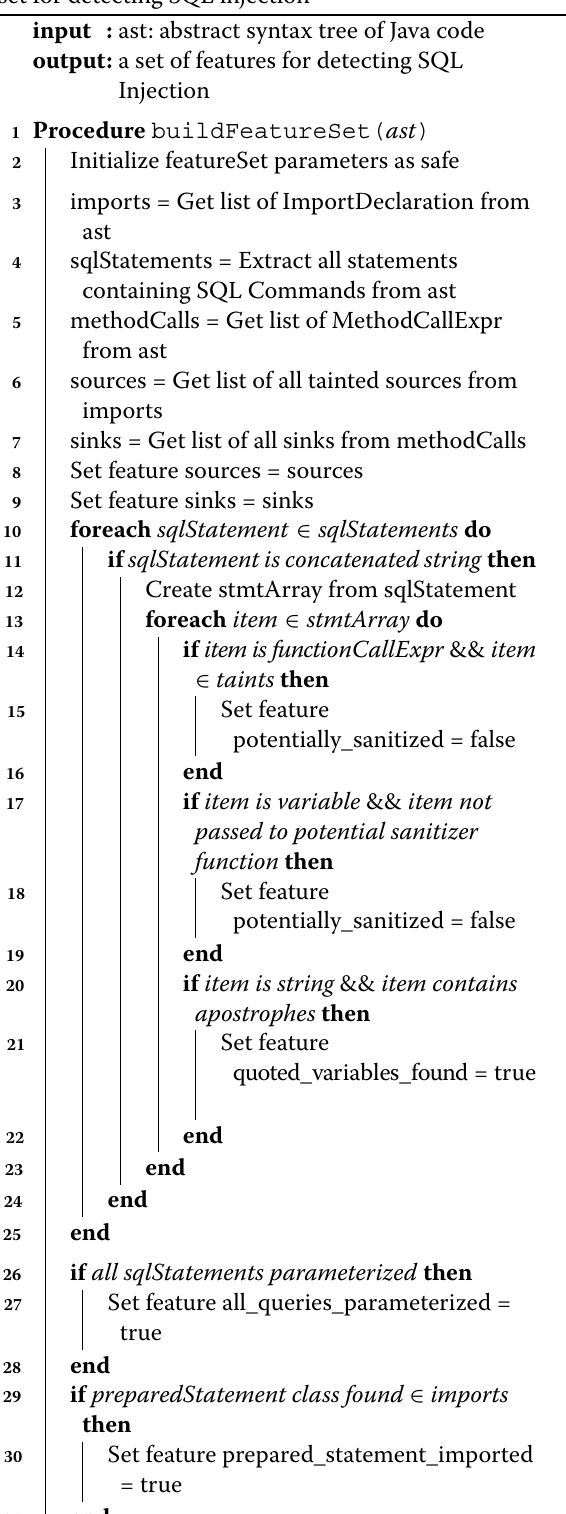
Algorithm 2: Procedure for building the feature set for detecting SQL injection